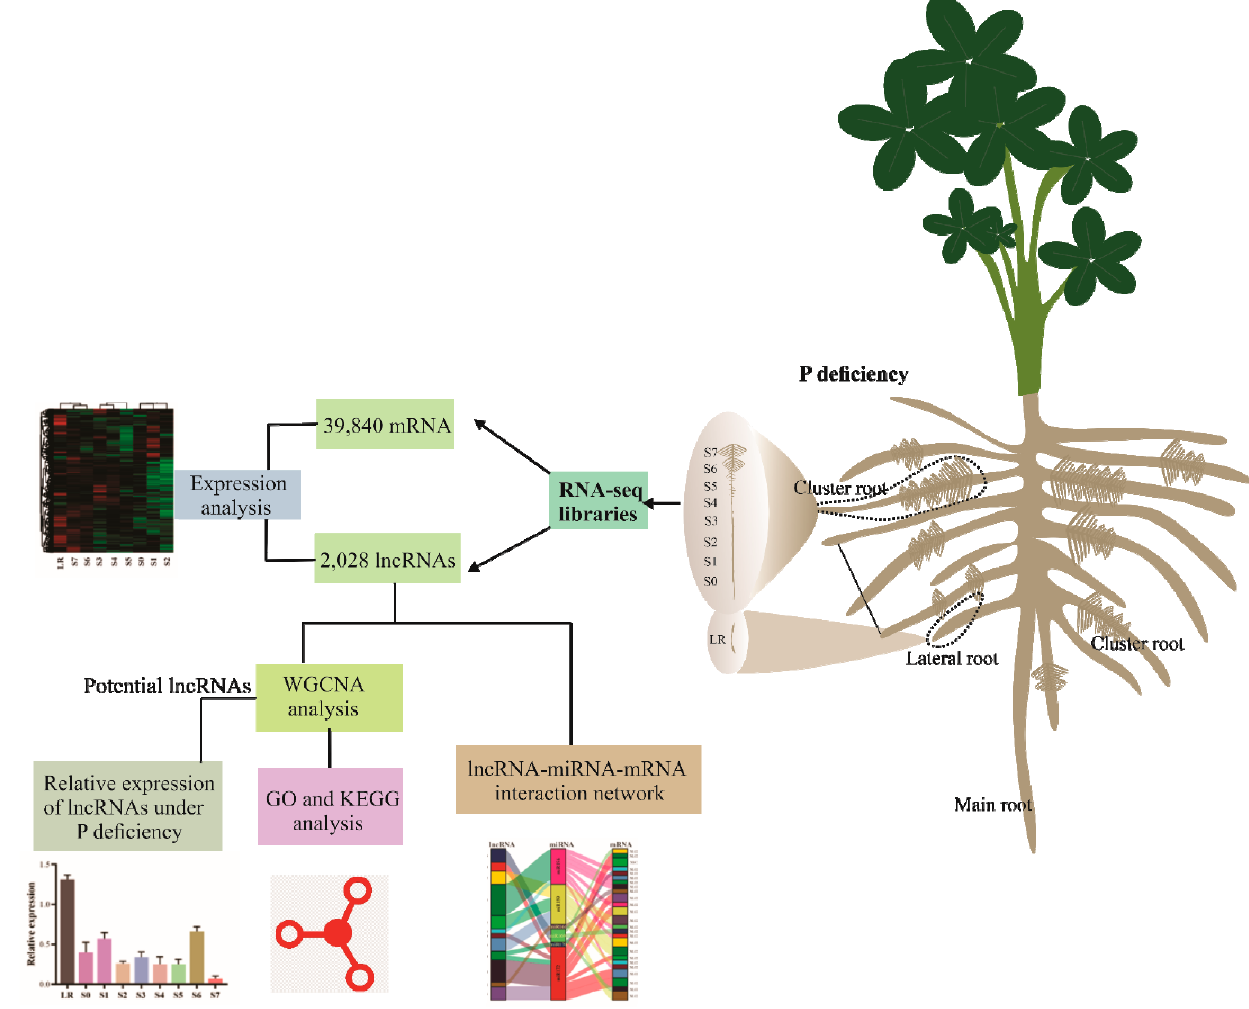
Figure 7. A conclusive schematic model of the findings on the identification of lncRNAs in white lupin responsive to P deficiency.